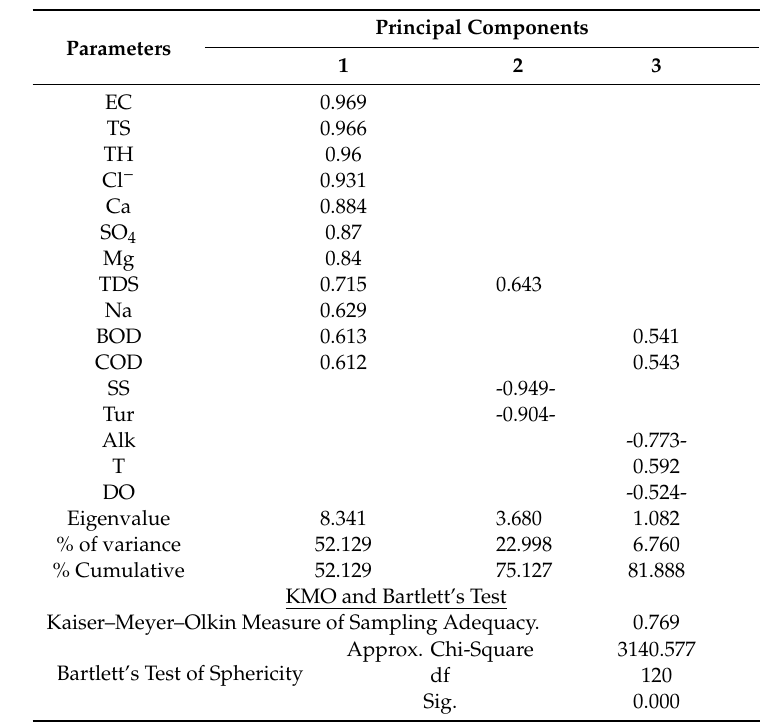
Table 2. The selected PCs, commonalities of selected parameters and the Kaiser–Meyer–Olkin (KMO) and Bartlett’s